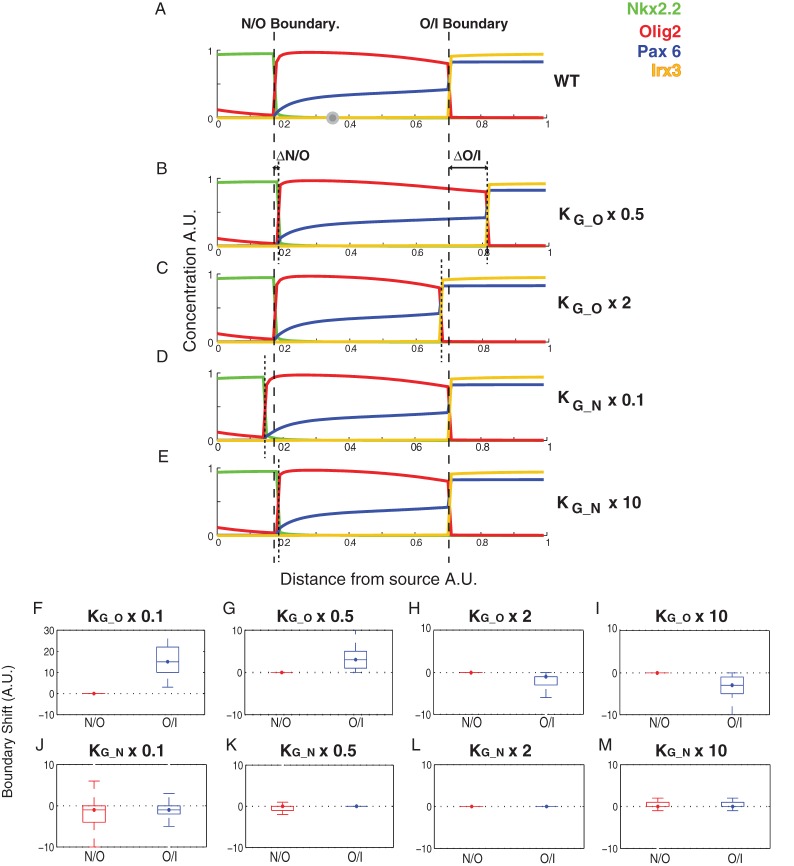
Boundary shifts caused by perturbations to Gli binding in the network model. (A) The steady-state WT pattern produced by the parameter set described in Fig. 3C after 100 h of Shh signalling. The neutral position, θ=0, for Olig2 and Nkx2.2 is indicated by the solid grey circle. The Nkx2.2/Olig2 (N/O) and Olig2/Irx3 (O/I) boundaries are indicated by dashed lines. (B-E) The patterns obtained when the model was simulated with perturbations to GBS affinity for either Olig2 or Nkx2.2. The resulting boundary shifts (ΔN/O and ΔO/I) are indicated by dotted lines. A twofold reduction (B) or increase (C) in the affinity of the GBS in the Olig2 enhancer results in a shift in the ventral boundary away (B) or towards (C) the morphogen source, and leads to an expansion (B) or contraction (C) in the overall domain size. A tenfold reduction (D) or increase (E) in the affinity of the GBS in the Nkx2.2 enhancer results in a slight reduction (D) or expansion (E) in its range of expression. (F-M) The positions of the Nkx2.2/Olig2 (N/O) and Olig2/Irx3 (O/I) boundaries were calculated using the algorithm described in the Materials and Methods. The shift in each boundary (ΔN/O and ΔO/I) caused by the perturbation to Gli binding affinity was calculated. The distribution of these boundary shifts from among the full posterior population of parameter sets is shown as a box blot (the median is identified by a large dot with strikethrough solid line, boxes are 25th and 75th percentiles, whiskers encompass ∼99% of the population, outliers are not shown). A population of 100,000 parameter sets was explored (derived by resampling the 1000 weighted particles obtained from ABC-SysBio). For each parameter set the model was perturbed from the WT case by altering the Gli binding affinity to either Nkx2.2 or Olig2. The distribution of boundary shifts from the WT location is indicated for the N/O (red) and O/I (blue) boundaries. Gli binding to Olig2 was reduced by a factor 0.1 (F) and 0.5 (G) or increased by a factor of 2 (H) and 10 (I). Gli binding to Nkx2.2 was reduced by a factor 0.1 (J) and 0.5 (K) or increased by a factor of 2 (L) and 10 (M).